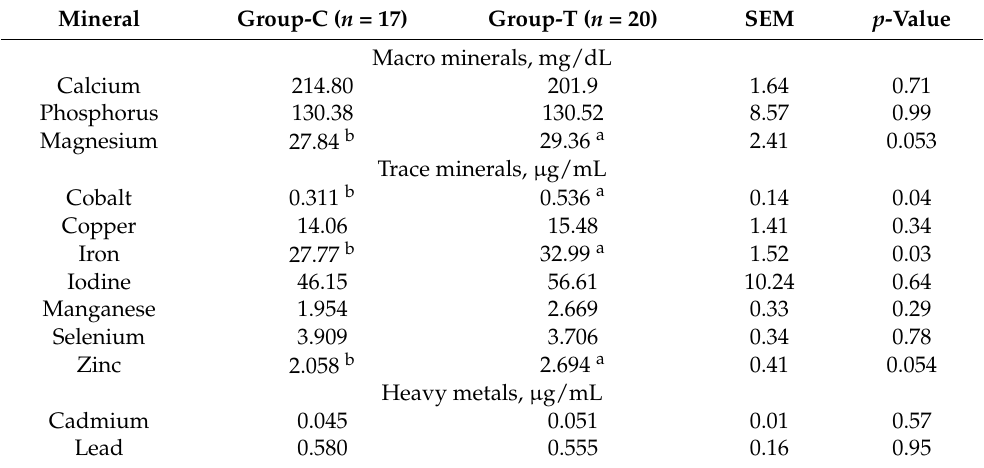
Table 3. Effect of concentrate supplementation to female camels beside alfalfa on element concentra- tion of milk during